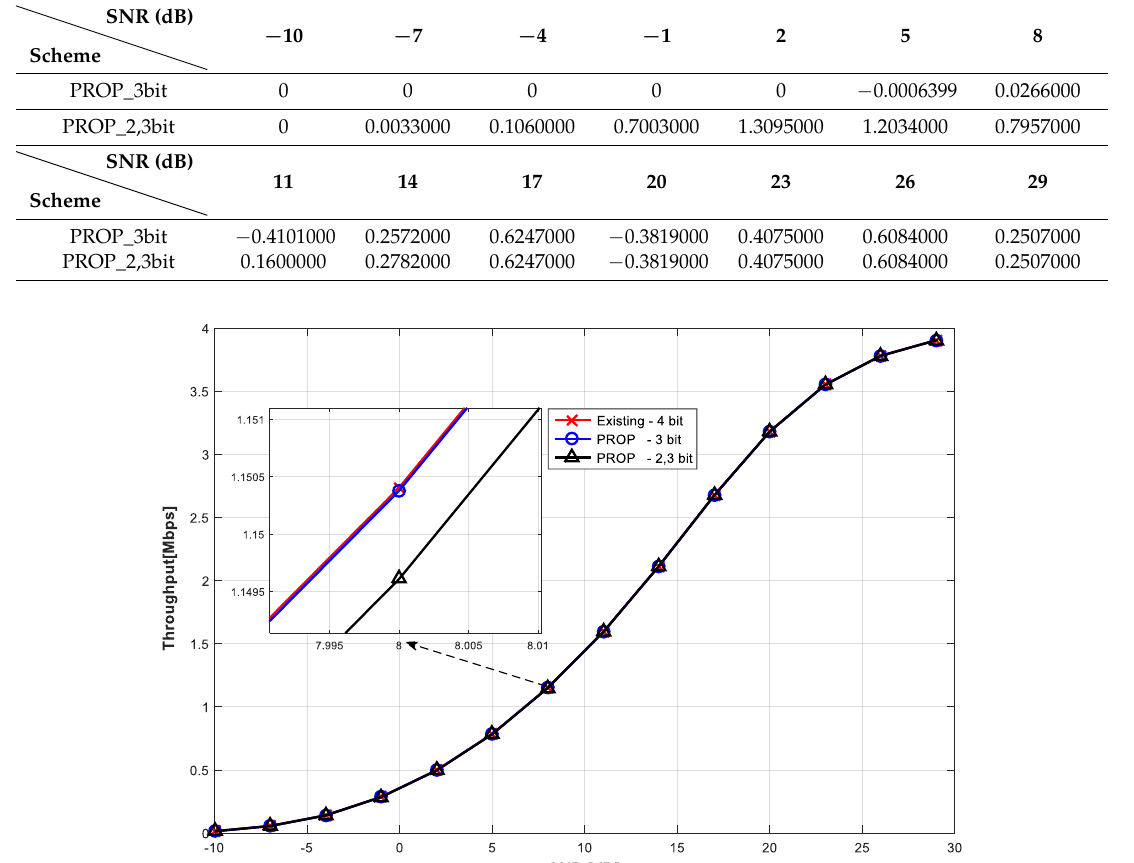
Table 5. System throughput differences between the existing and the proposed CQI feedback schemes (kbps).